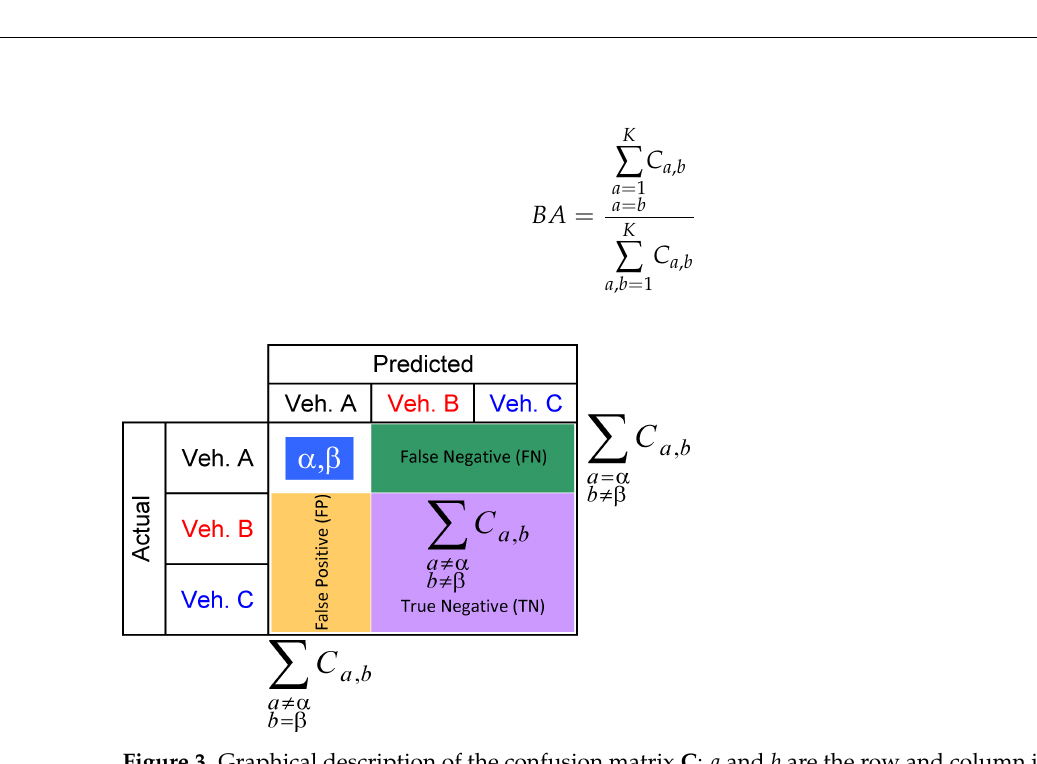
Figure 3. Graphical description of the confusion matrix C : a and b are the row and column indices, α and β are the positions of the specific cells (the first one in this example is for graphical reasons), summation expressions indicate how to revert to a binary confusion matrix